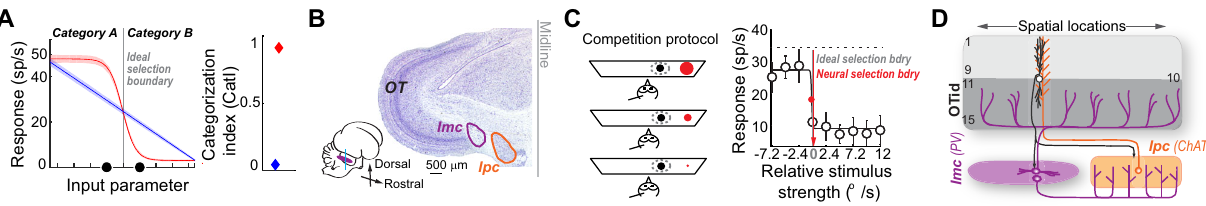
Fig. 1 Categorical neural responses in the owl midbrain network. A Left: Schematic comparing two mathematically generated ‘ neural ’ response pro fi les, as a function of continuously varying input. Red — categorical response pro fi le, blue — linear response pro fi le. Gray vertical line: ideal selection (or categorization) boundary. Translucent band: variability in responses (s.e.m); fano factor of 6 used to generate these responses (Methods). Filled black dots: Two competing inputs just straddling the selection boundary: they are nearly equal but belonging to different categories, each at a distance of 3 units from the selection boundary. Right: Categorization index (CatI); characterizes strength of categorization of response pro fi les in left panel. CatI is insensitive to scaling of response means and accounts for response variability (Fig. S1A – C; Methods) 6,8 . B Midbrain selection network in barn owl. Inset: Side view of owl brain. Vertical blue line: line of section. Main: Coronal section through owl midbrain showing optic tectum (OT), isthmi pars magnocellularis (Imc, GABAergic, parvalbumin-positive, purple outline), and isthmi pars parvocellularis (Ipc, cholinergic, orange outline). C Left: Schematic of “ competition protocol ” used in (non-behaving) owls 9,22 . A stimulus of fi xed strength (black dot) is presented inside the spatial receptive fi eld (RF; dashed oval) of a neuron, while a competitor (red dot) of varying strength is presented far outside the RF. Strength of the stimuli is controlled by their loom speeds (°/s); denoted here by size of dots. Right: Categorical ( “ switch-like ” ) response pro fi le of a neuron in the intermediate and deep layers of the OT (OTid) measured using the competition protocol in left panel. Red vertical line: neural selection boundary; indicates the relative strength at which neural responses switch from being at a high level to a low level. Gray vertical line: ideal selection boundary; indicates the relative strength of 0, at which the two stimuli are equally strong. The neural selection boundary nearly overlaps with ideal one. Data reproduced with permission 9 . D Schematic of connectivity within the avian midbrain selection network. Layers (1 – 15) of OT are shown. OTid: intermediate and deep layers (layers 11 – 15). Cholinergic Ipc neuron (orange circle) receives focal input from OT (black circle, layer 10), and send projections focally back to OT (orange projections). GABAergic Imc neuron (purple circles) receives focal input from OT (black circle, layer 10), and but sends inhibitory projections broadly across OTid as well as Ipc (purple projections). Consequently, Imc neurons suppress OTid responses via two pathways: (i) the direct pathway to the OTid 31 (Imc → OT), and (ii) the indirect pathway that inhibits the potent point-to-point cholinergic ampli fi ers of OTid, namely the Ipc 31,33 (Imc → Ipc → OT). See also Fig. S1. Source data are provided as a Source Data fi